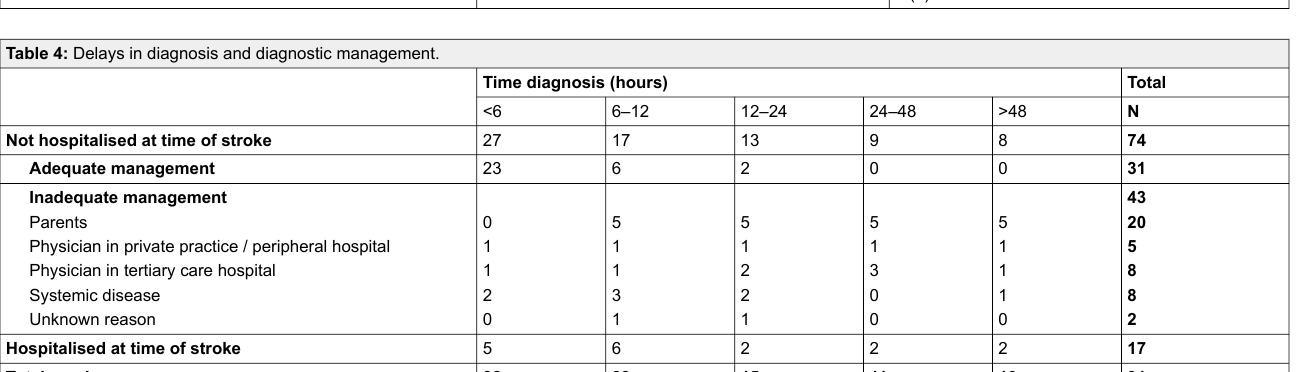
Table 4: Delays in diagnosis and diagnostic